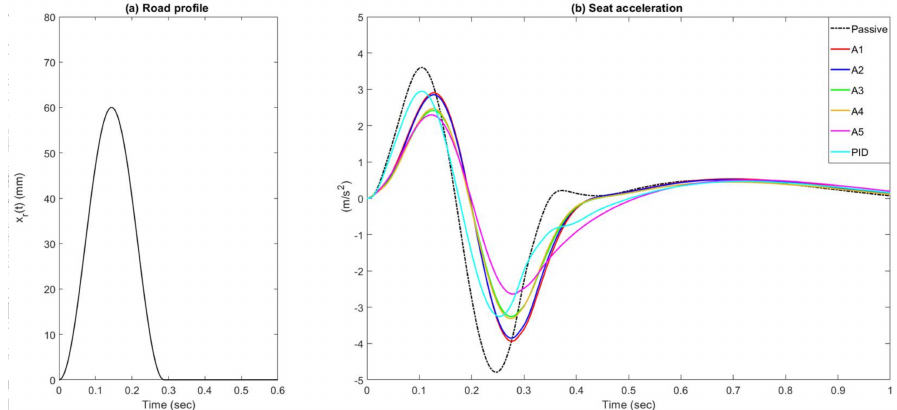
Figure 8. Simulated seat suspension acceleration of the passive and active systems when subject to a bump road input. ( a ) Road profile; ( b ) Seat